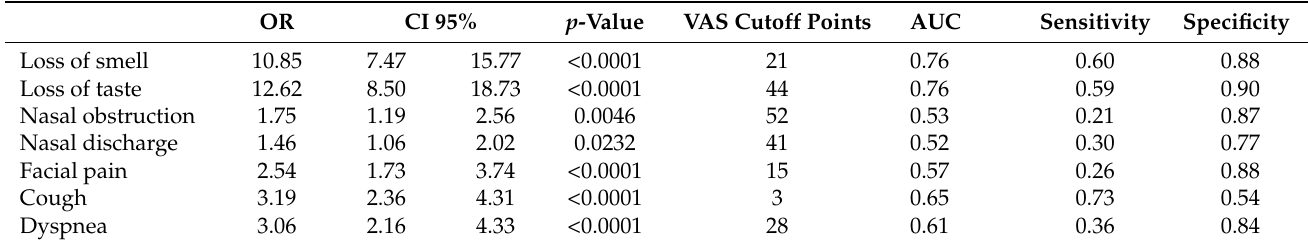
Table 2. Crude odds ratio (OR) for the associations between the VAS collected for each symptom and COVID-19 test. The VAS cut-off points that better predicted test positivity (by maximizing the Youden Index) are also shown, together with their sensitivity and